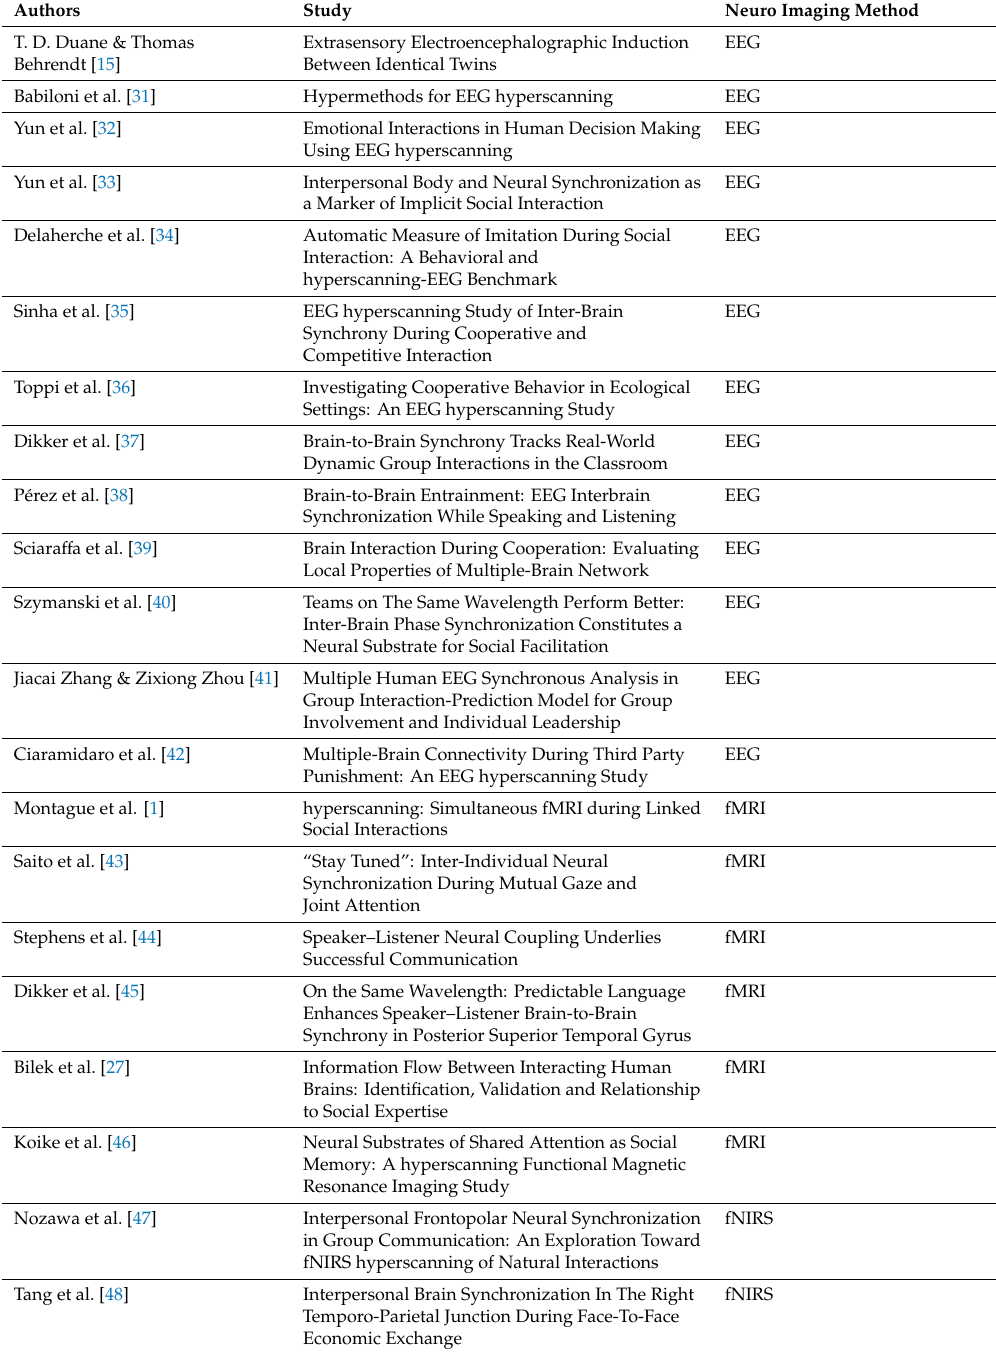
Table 1. A list of hyperscanning studies based on the neuroimaging methods used. The studies listed in the table reflect only a subset of those used for the purpose of the literature